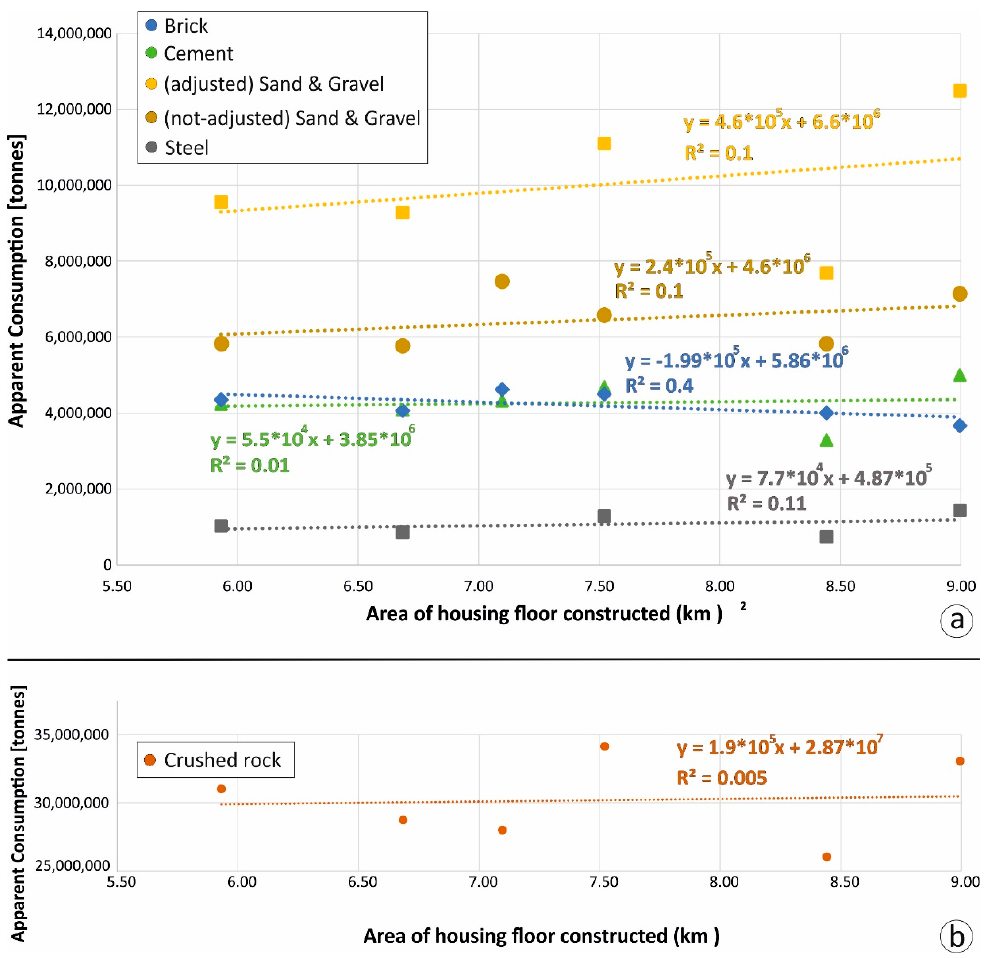
Figure 9. Correlation between the area of housing floor constructed and AC of bricks, cement, (adjusted) sand & gravel, (not-adjusted) sand and gravel and steel ( a ) and crushed rock aggregates ( b ). Note: a different scale for the consumption projection of crushd rock is used. Linear fitting equations and R 2 values for each variable are provided.